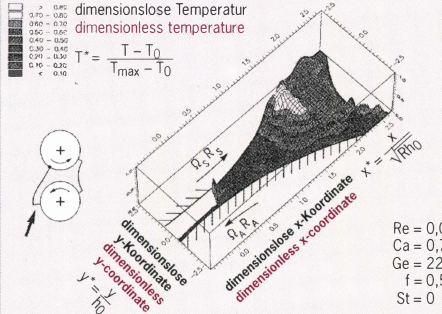
Fig. 6: Comparison of measured· and calculated coating thickness as a function of Reynolds number and friction number